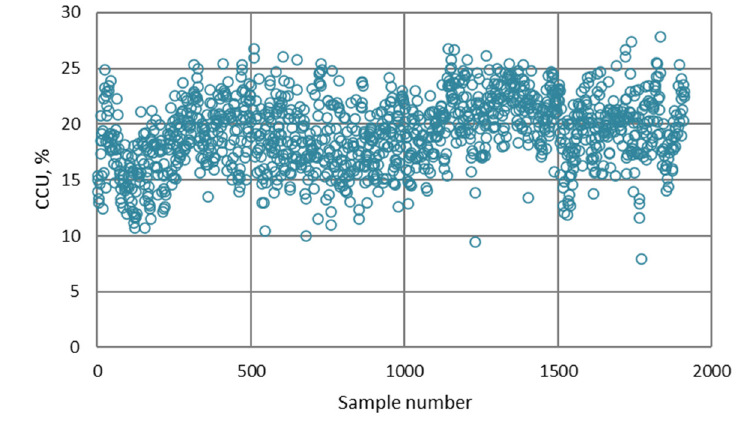
Figure A26. NN1 model—training dataset.